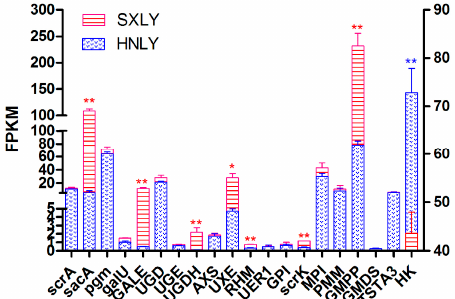
Figure 6. FPKM analysis of candidate unigenes involved in PSP biosynthesis. For a given gene, expression is significantly different between germplasms at * p < 0.05 and ** p < 0.01. Values on y-axis along right side of figure pertain to HK ; values along left side are for all other genes.